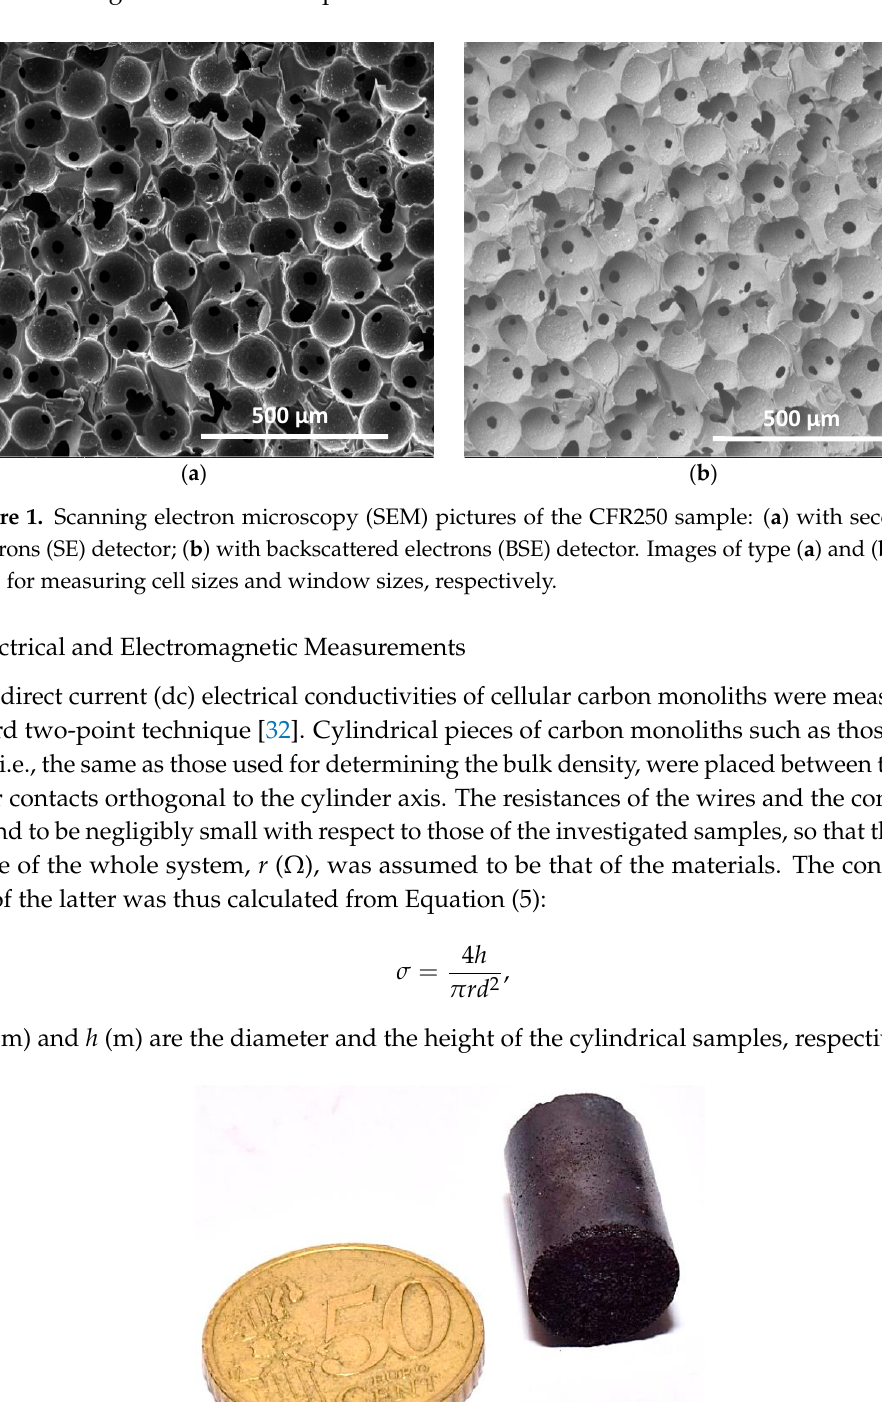
Figure 2. Typical cellular carbon monolith sample (here CRF450) obtained after pyrolysis and used as such for electrical conductivity and bulk density measurements.